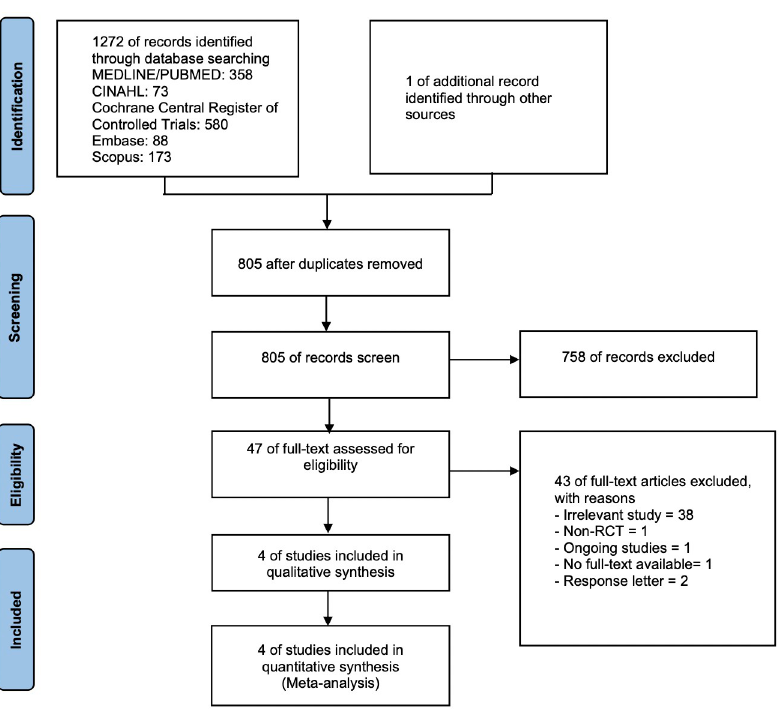
Fig 1. PRISMA flow diagram of the study selection for the systematic review and